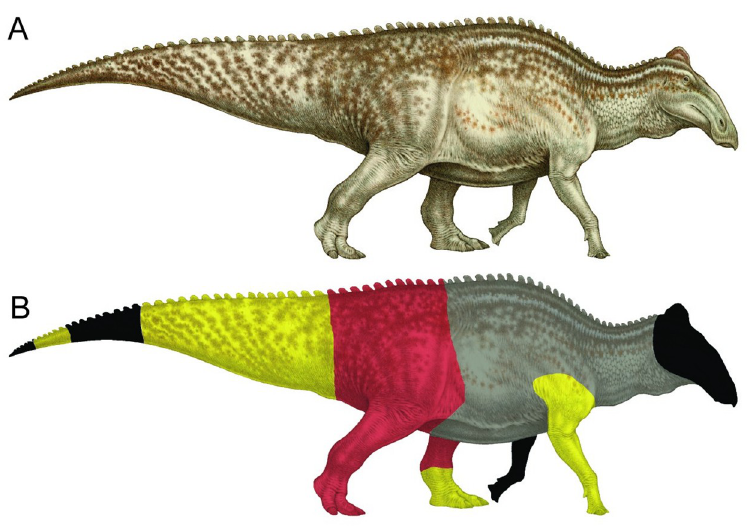
Fig 2. Distribution and current state of preparation of preserved skin on NDGS 2000. (A) Life reconstruction of Edmontosaurus sp. based on NDGS 2000 in right lateral view. (B) Areas of skin preservation in NDGS 2000. In (B), black areas indicate portions of the skeleton apparently missing from the specimen, light grey areas indicate regions where the skeleton is preserved but no skin is currently preserved, red areas indicate regions where skin is present and is still undergoing preparation, yellow areas indicate areas where the skin is fully prepared and were examined in this study. Paleoart by Natee